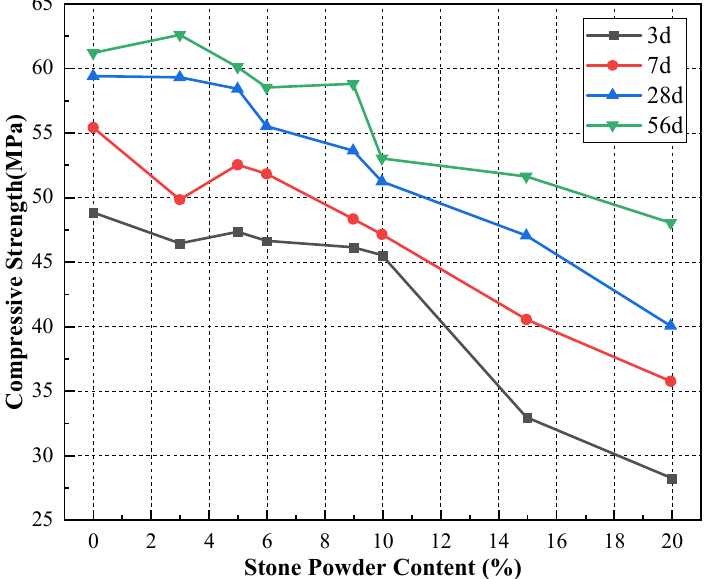
Figure 7. Concrete compressive strength versus stone powder content curve.